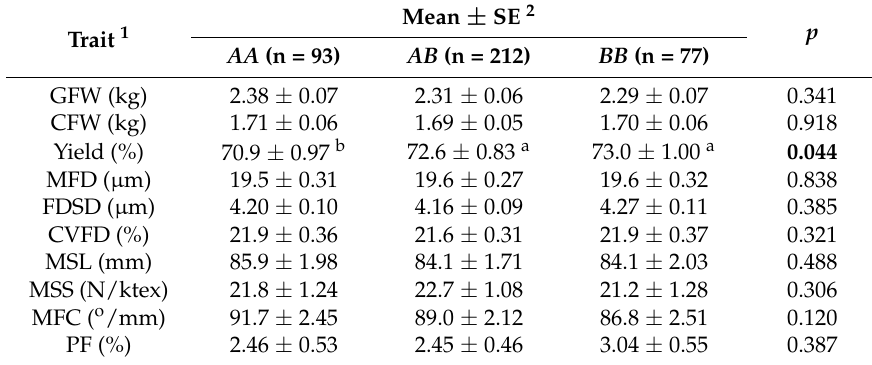
Table 3. The effect of KRTAP22-1 genotype on various wool traits.